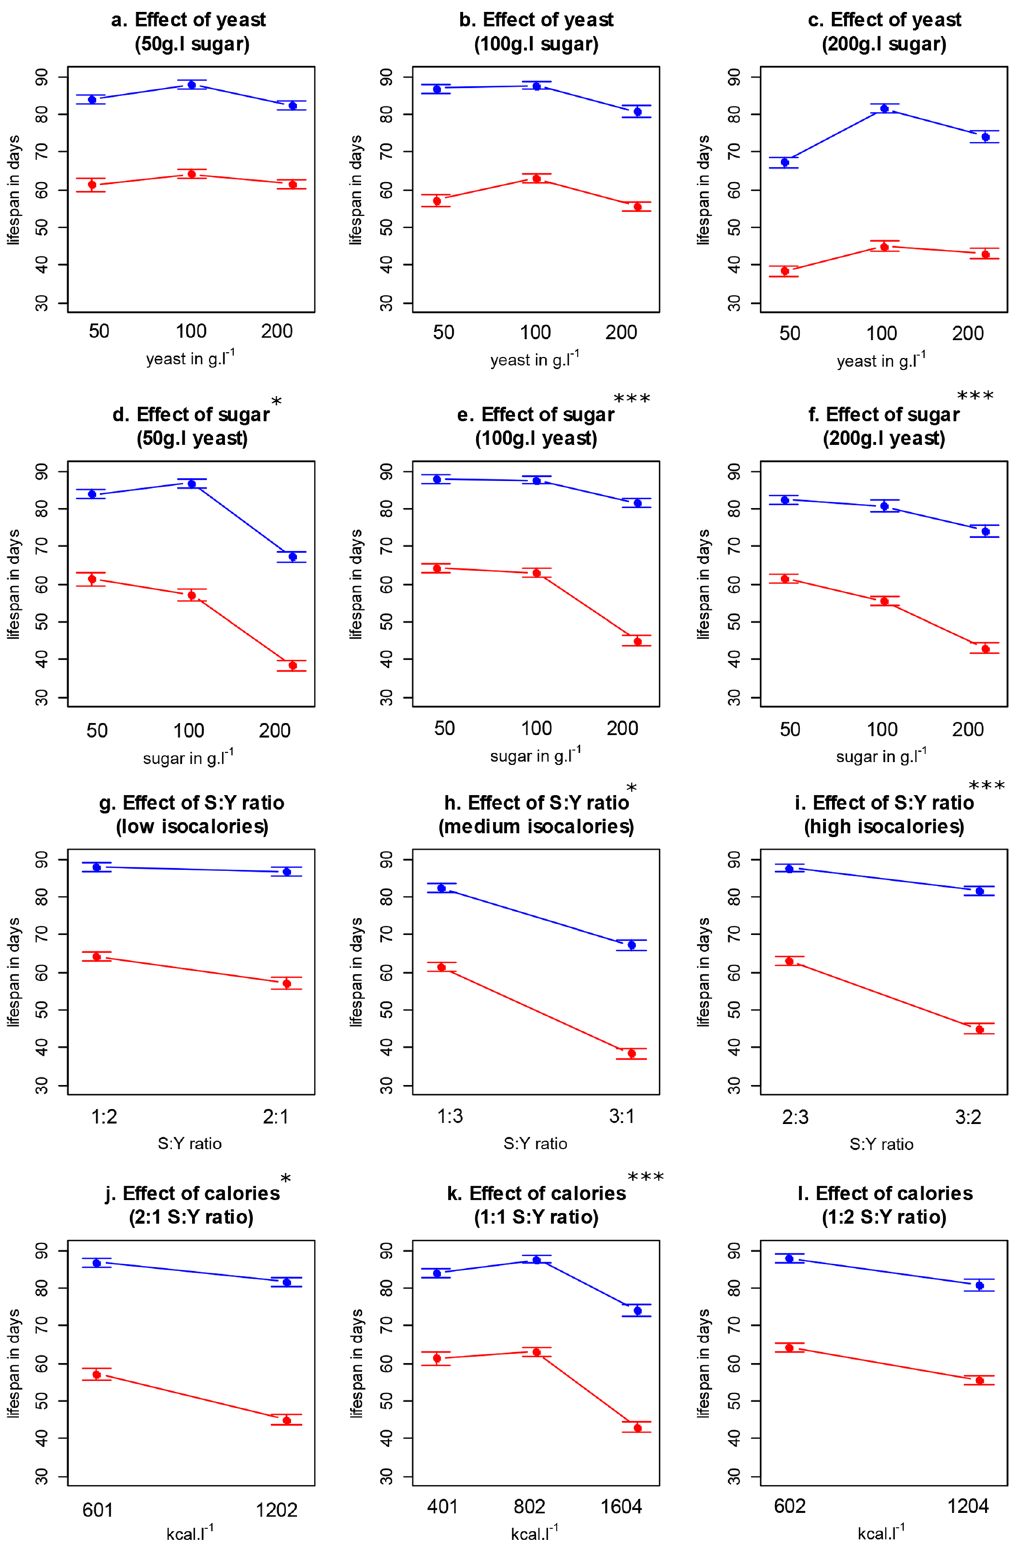
Fig. 2 Lifespan interaction plots (mean +/ − standard error) display how the lifespan response to nutritionally different DR interventions can be differently affected by the knockout ( blue lines represent dilp2-3,5 mutants, red lines control fl ies), a – c effect of dietary yeast on different sugar levels; d – f effect of dietary sugar on different yeast levels, g – i effect of S:Y ratio on different caloric levels; j – l , effect of calories on different S:Y ratio ’ s. Asterisks indicate a signi fi cant interaction between the dilp2-3,5 knockout and diet regimen under consideration (coxph). * p < 0.05, ** p < 0.01, *** p <